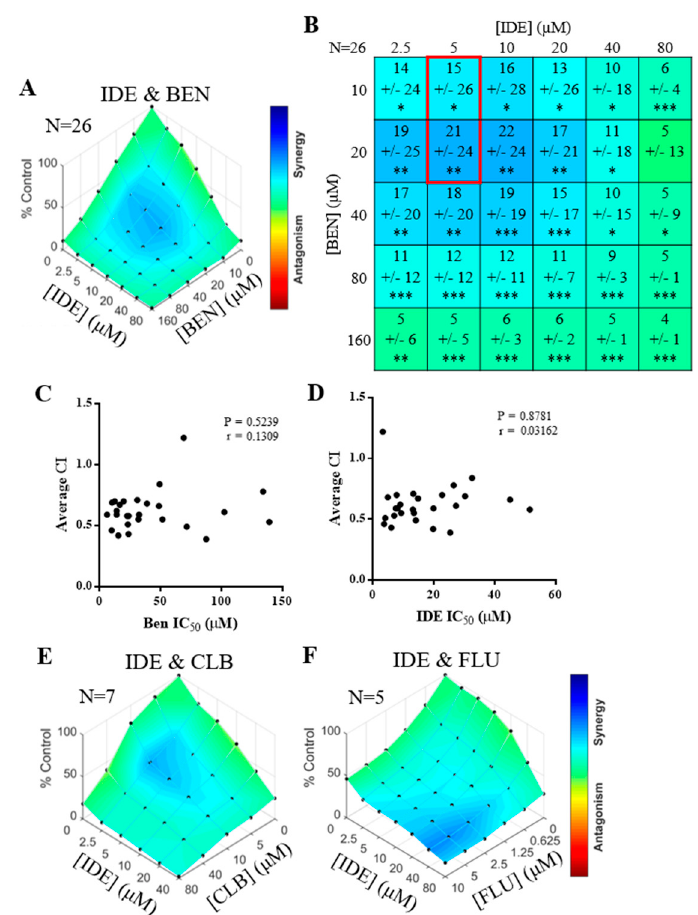
Figure 2. Idelalisib (IDE) is synergistic with bendamustibe (BEN) and other chemotherapies. Cell death in primary chronic lymphocytic leukemia (CLL) samples 72 h post drug treatment. ( A ) Combenefit synergy plots from combining BEN and IDE representing the average difference in cell death compared to that predicted by the single dose-response curves for each agent in 26 CLL samples. Blue—synergy, green—additivity and, red—antagonism ( B ) Statistical table from A with 95% confidence intervals (* p < 5 ×10 − 2; ** p < 10 − 3 , *** p < 10 − 4 ) highlighting the clinically relevant concentrations (red box). ( C , D ) Graphs showing the correlation between the drug concentration required to inhibit cell viability by 50% (IC 50 ) of BEN ( C ) or IDE ( D ) to the average combination index (CI) value of the clinically relevant single agent concentrations (red box in B ). ( E , F ) Combenefit synergy plots showing synergy between IDE and chlorambucil (CLB) ( E ) or fludarabine (FLU) ( F ).